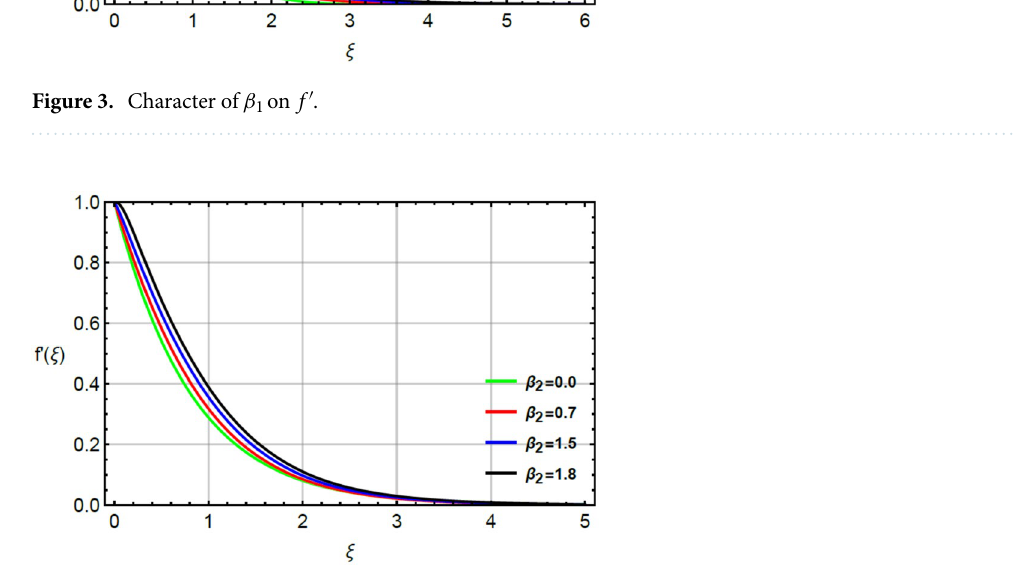
Figure 4. Character of β 2 on f ′